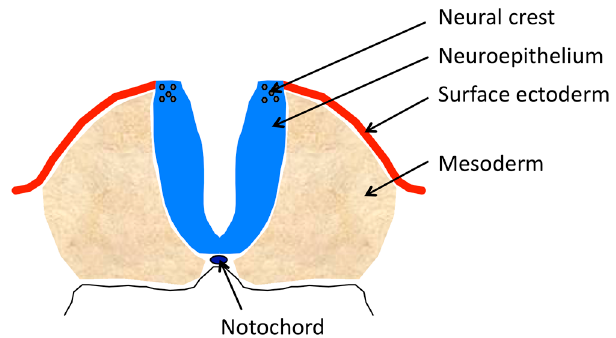
Figure 1. Diagram of a transverse section of upper spinal neural folds of an E8 mouse embryo before neural tube closure. Somites not shown.